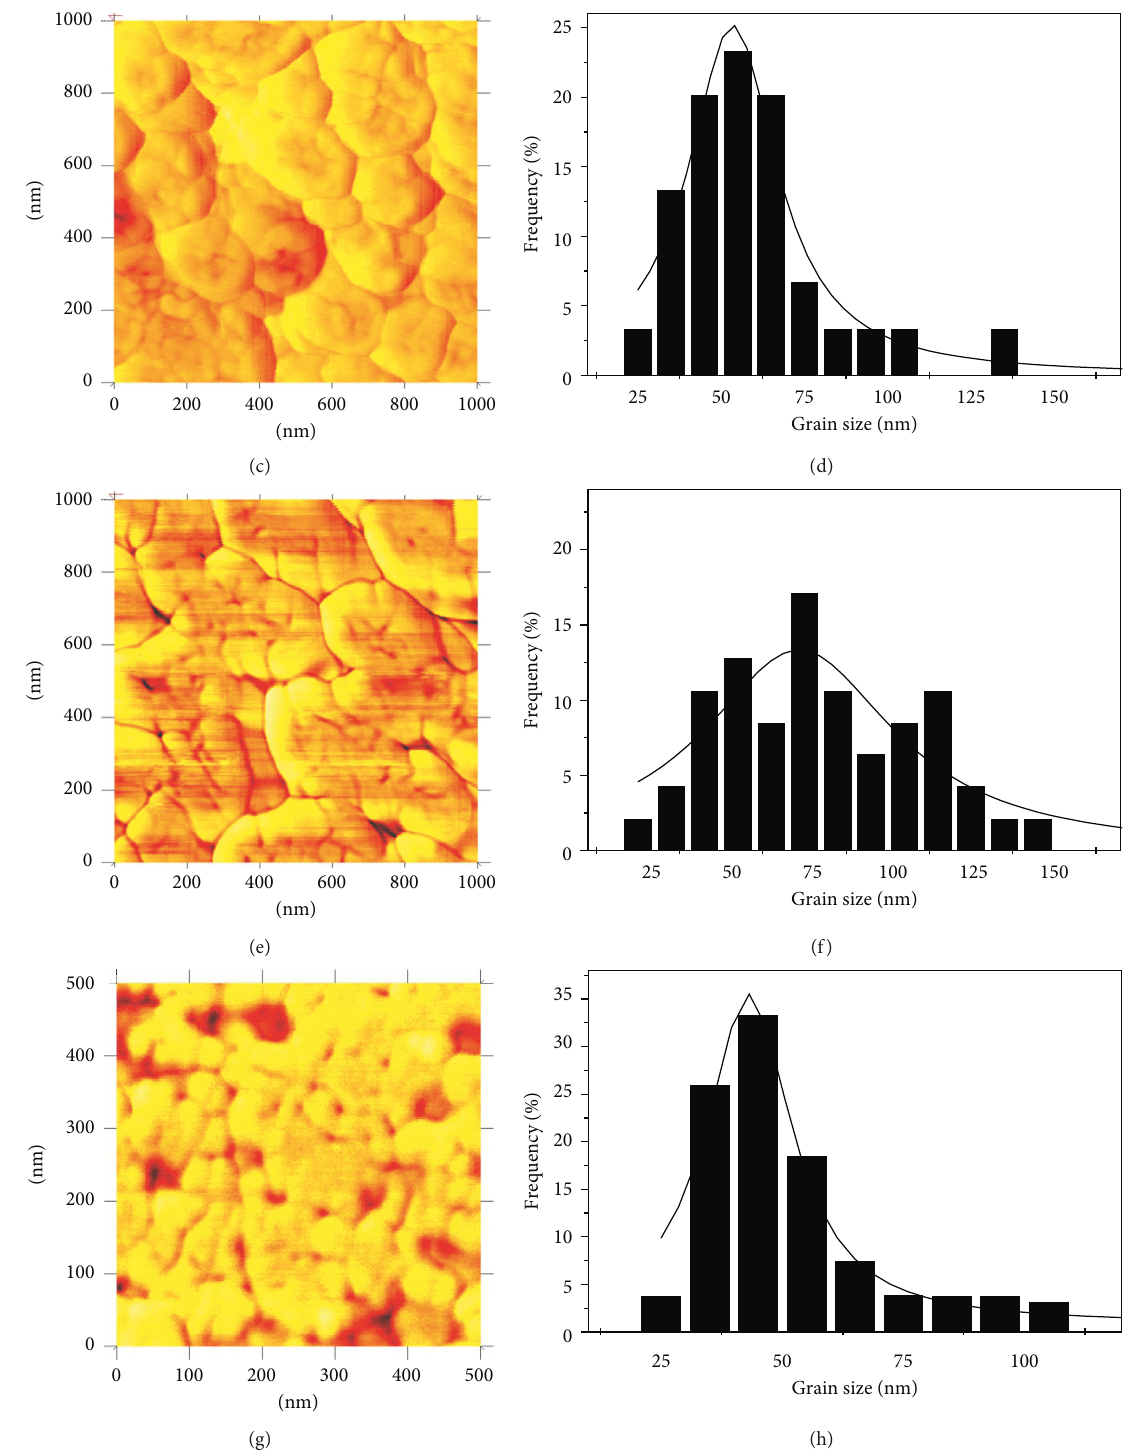
Figure 6: AFM pictures (a, c, e, g) and grain size distribution (b, d, f, h) of the mechanically alloyed and consolidated bulk nanocomposites: Ta-5Y 2 O 3 (a, b), Ta-10Y 2 O 3 (c, d), Ta-20Y 2 O 3 (e, f), and Ta-40Y 2 O 3 (g,